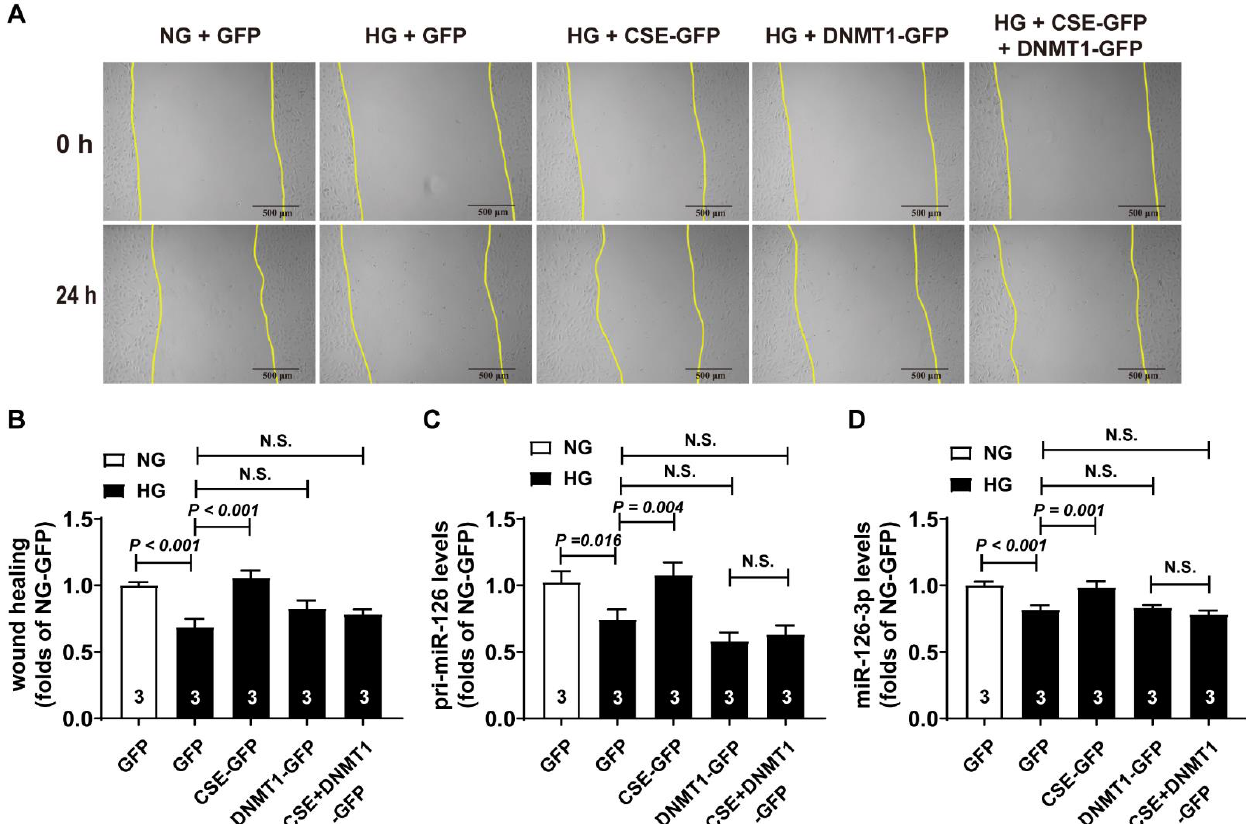
Figure 6. Upregulation of endogenous H 2 S increased the transcription of pri-miR-126 via decreasing the DNMT1 level in endothelial cells. ( A , B ) Representative images of scratch wound healing in HUVECs with CSE or DNMT1 overexpression ( A ) and statistical analysis ( B ); bar = 500 μm, n = 3. ( C ) pri-miR-126 level in HUVECs with CSE or DNMT1 overexpression; n = 3. ( D ) miR-126-3p level in HUVECs with CSE or DNMT1 overexpression; n = 3.